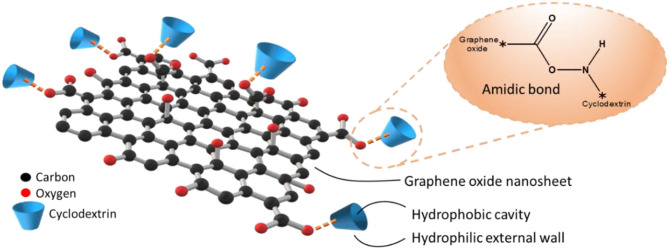
Scheme illustrating a graphene-based sorbent functionalized with cyclodextrins through peptide bonds.